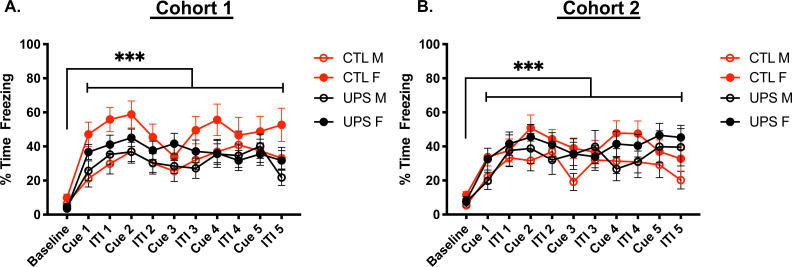
Exposure to acoustic-cue in a novel environment led to robust increase in freezing but no consistent effects of rearing, sex, or interaction.Freezing behavior in response to tone are shown for cohort 1 (A) and cohort 2 (B). Exposure to tone in the novel context led to a robust increase in freezing that was seen in both cohorts (cohort 1, Repeated measures ANOVA Greenhouse–Geisser: F (7.22, 491.16)=22.184, p<0.001, hp2 = 0.25, with Sidak’s post-hoc on freezing episodes: p<0.001. Cohort 2, Repeated measures ANOVA Greenhouse–Geisser: F (6.58, 407.95)=16.96, p<0.001, hp2 = 0.22; Sidak’s post-hoc on freezing episodes: p<0.001). Between-subject analysis found no consistent effects of rearing, sex, or interaction on freezing behavior during cue exposure (tone on) or inter-trial intervals (tone off).